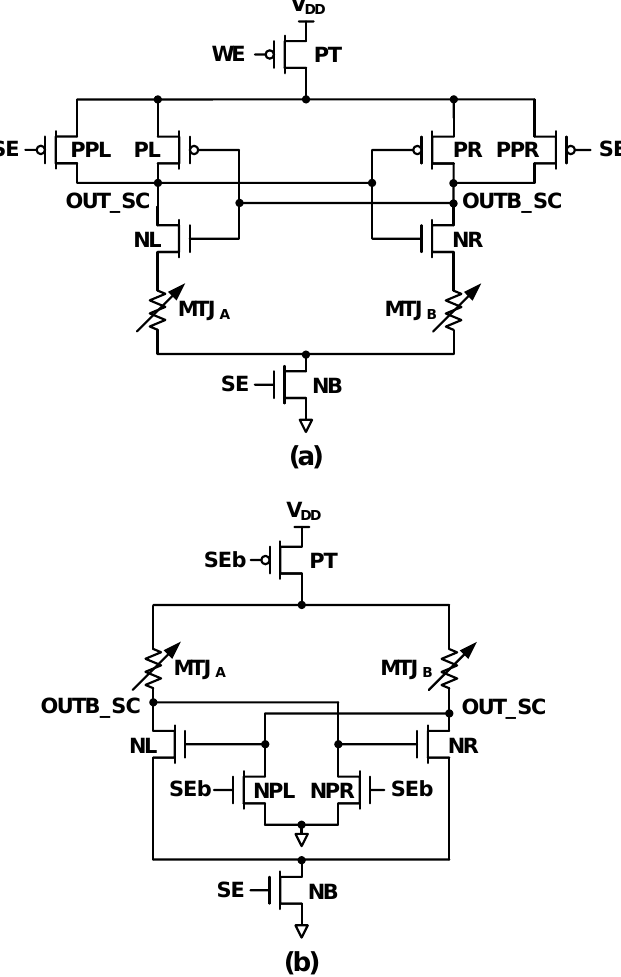
Figure 3. Circuit diagrams of cross-coupled-based SCs for NV-FFs: ( a ) CCI-SC [7,8]; ( b ) Proposed CCN-SC.